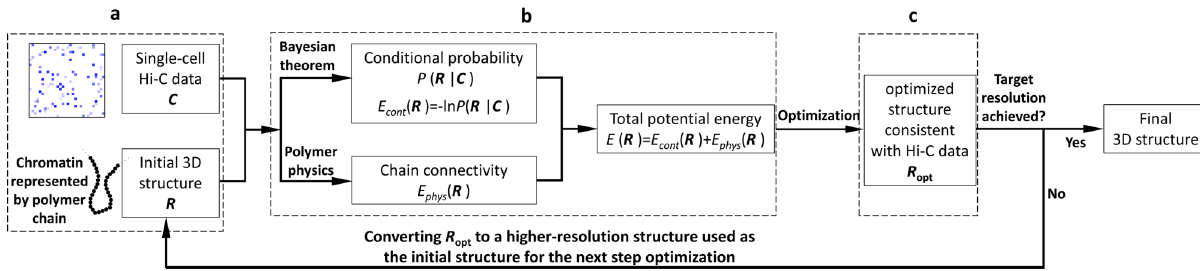
Fig. 1 Schematic illustration of Si-C method for inferential structure determination from single-cell Hi-C data. a Building models of chromosomes by using polymer chains consisting of contiguous, equally sized beads, and assigning the experimentally observed contacts to the pair of chromatin beads containing the corresponding restriction fragment ends. b De fi ning the total potential energy of a 3D conformation. c Performing a structure optimization by using the steepest gradient descent algorithm from an initial conformation to minimize E R ð